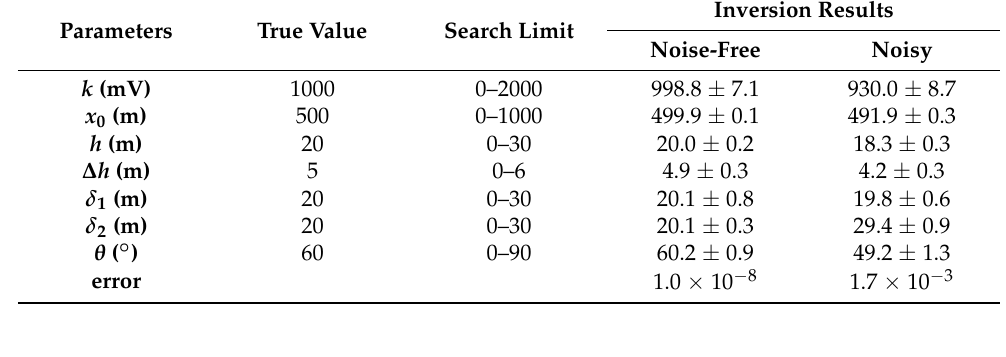
Table 3. Inverted model parameters (Model 2) of synthetic data from 2D dipping layer/bed.